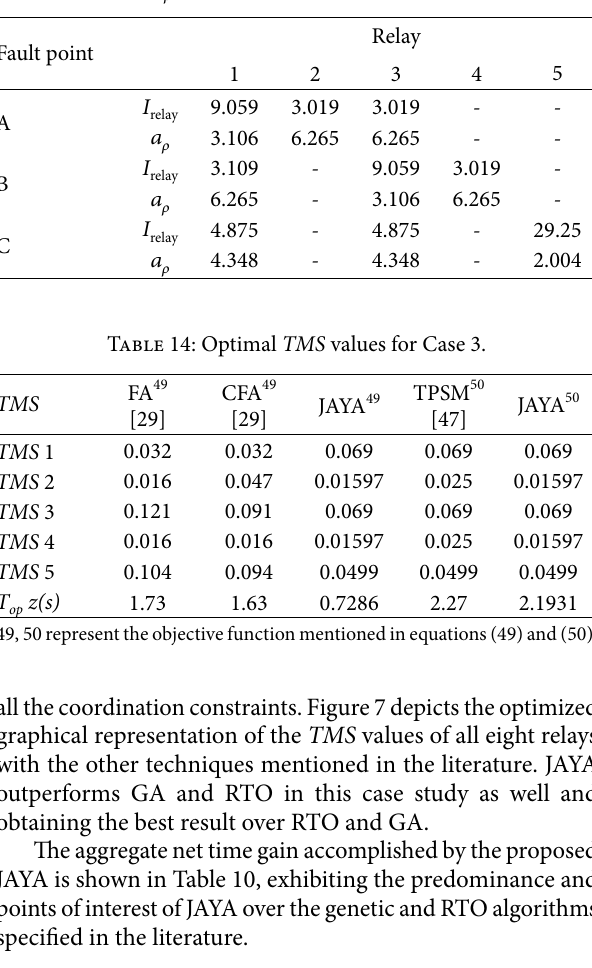
Table 13: 𝑎 Constants and relay currents for Case 3. 𝜌